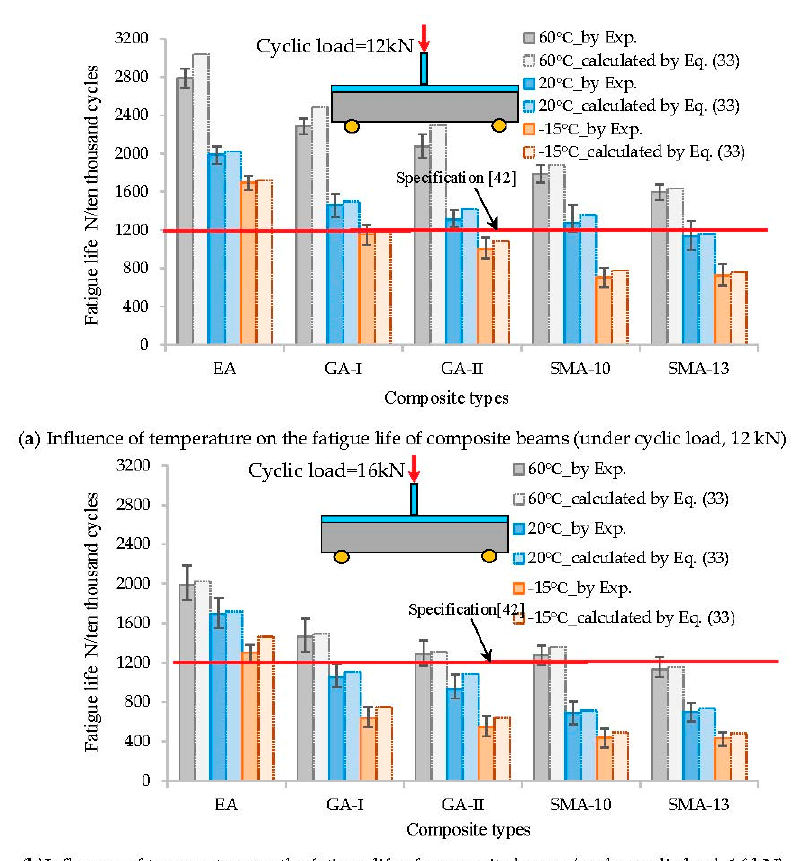
Figure 8. Comparison between fatigue life prediction and measurement under different loading cycle levels and test conditions (unit: ten thousand cycles): ( a ) cyclic load = 12 kN; ( b ) cyclic load = 16 kN.